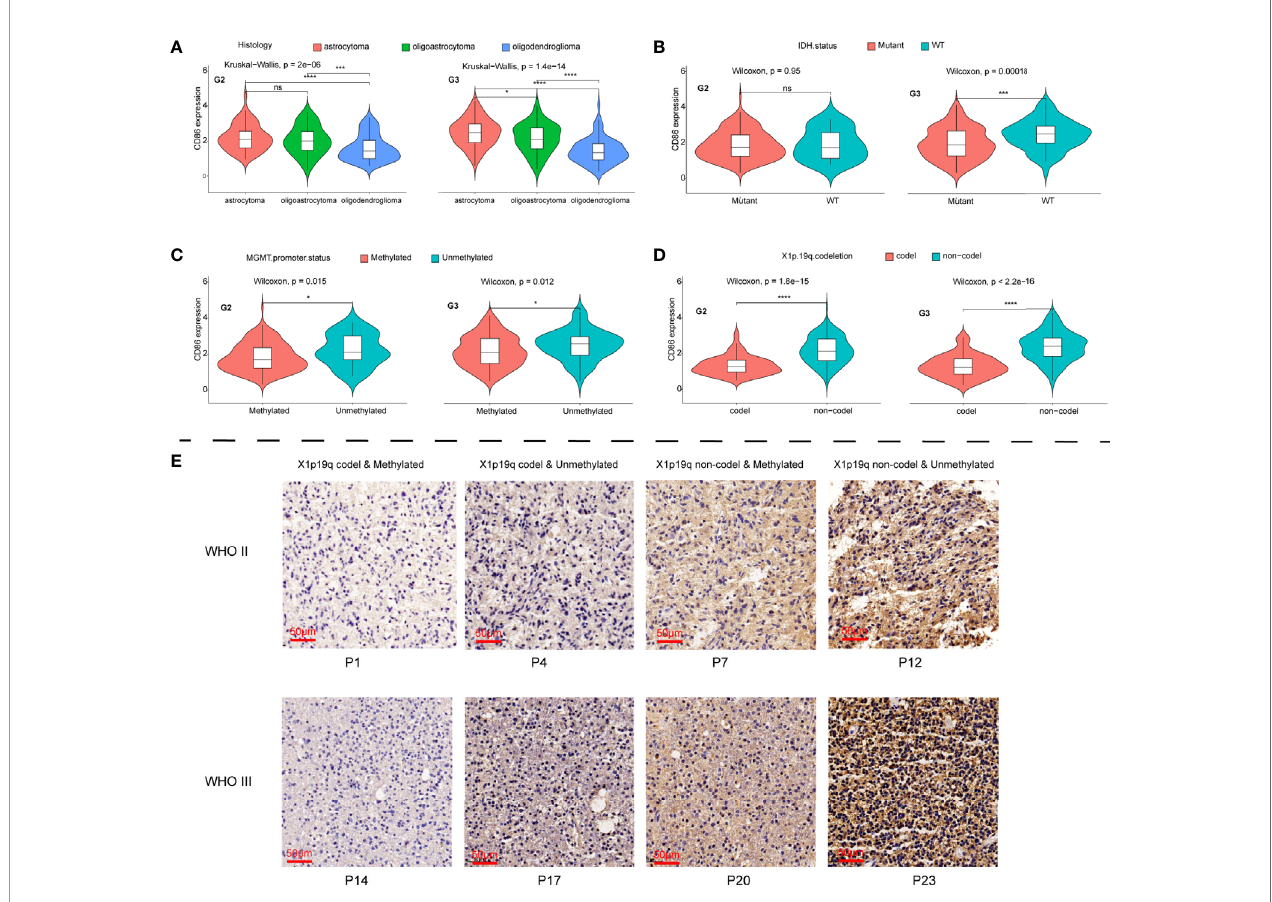
FIGURE 5 | Comparisons of CD86 expression with different histological/molecular subtypes of LGG strati fi ed by tumor grade. (A) CD86 expression in astrocytoma, oligoastrocytoma and oligodendroglioma. (B) CD86 expression in IDH mutant and WT of LGG. (C) CD86 expression in MGMT-methylated LGG versus unmethylated type. (D) CD86 expression in LGG with X1p/19q codeletion versus non-codeletion. (E) IHC staining of CD86 among different molecular subtypes regarding status on MGMT methylation and X1p/19q codeletion. *p<0.05 **p<0.01, ***p<0.001, ****p<0.0001, ns: not signi fi